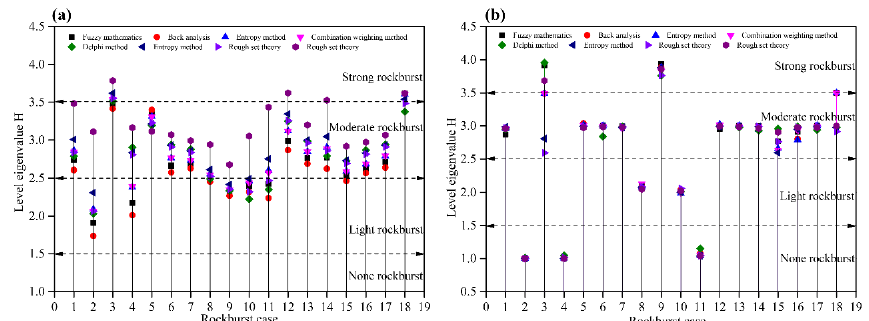
Figure 10. The prediction results of 18 rock burst cases before and after SRMD optimization: ( a ) initial SRMD and ( b ) optimized SRMD under eight different weight assignment conditions.